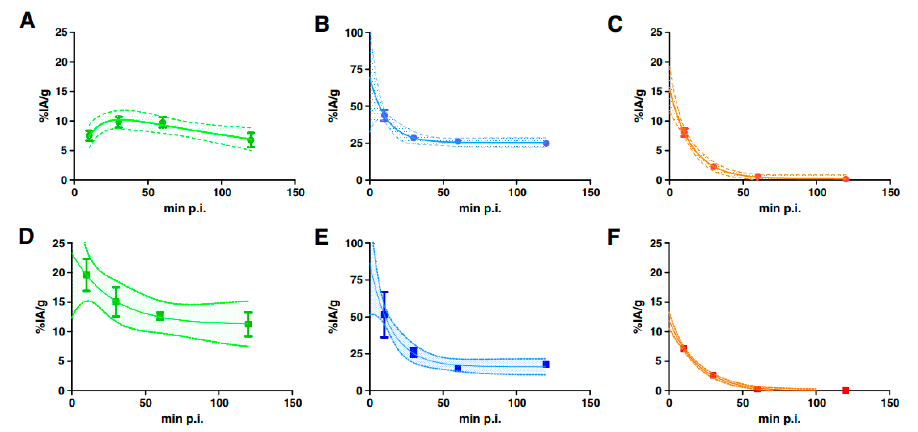
Figure 4. Selected pharmacokinetics of 213 Bi-DOTATATE in H69 ( A – C ) and CA20948 ( D – F ) tumor-bearing animals: uptake in tumors ( A , D ) and kidney ( B , E ), and radioactivity in blood ( C , F ) [63].